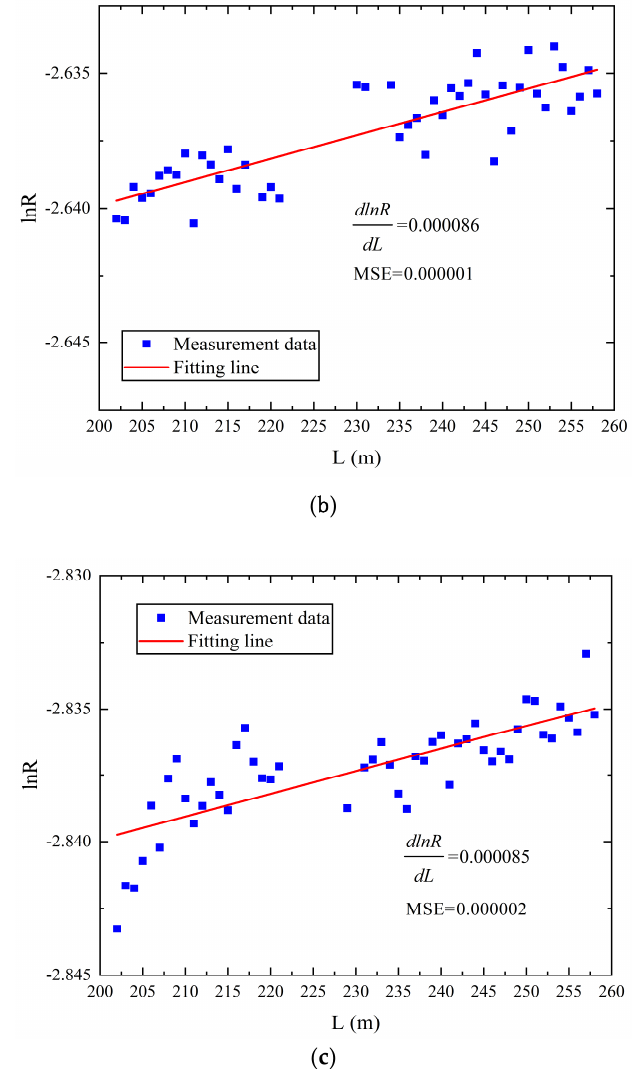
Figure 9. ( a ) Relationship between the location and logarithmic ratio of the optical power at −60 °C ; ( b ) relationship between the location and logarithmic ratio of the optical power at −110 °C ; ( c ) relationship between the location and logarithmic ratio of the optical power at −120 °C.